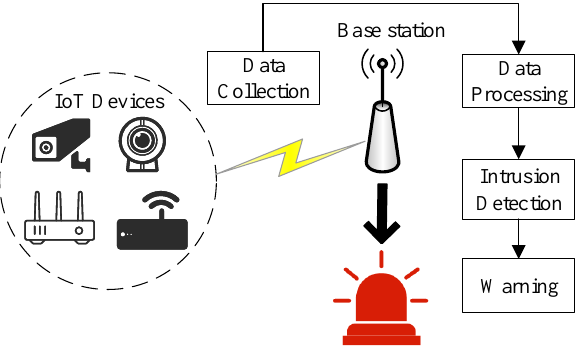
Figure 2. Intrusion detection model.